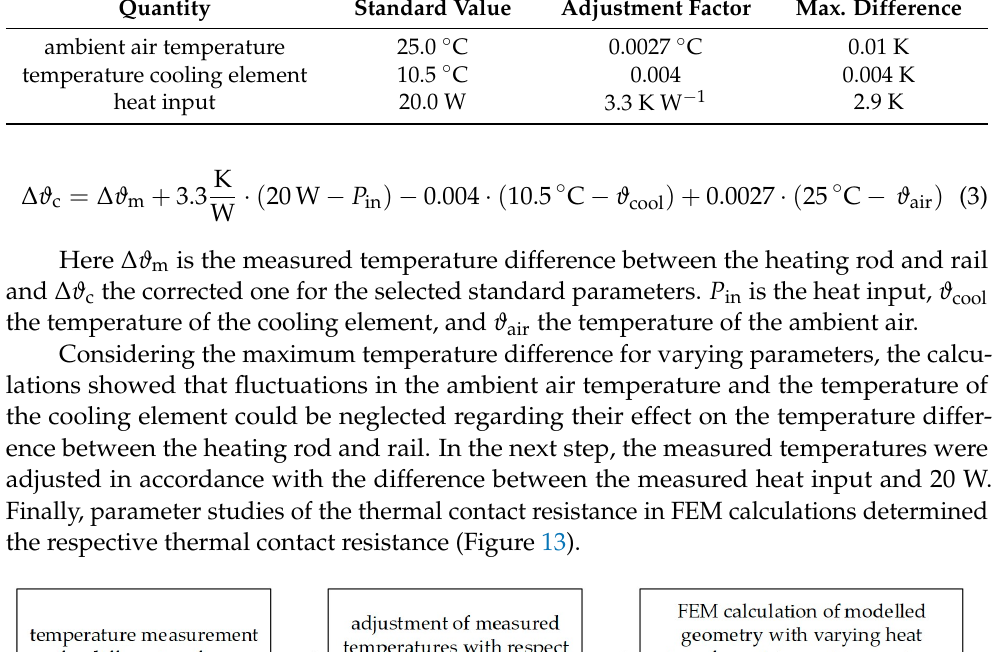
Table 2. Varying parameters with the respective range.